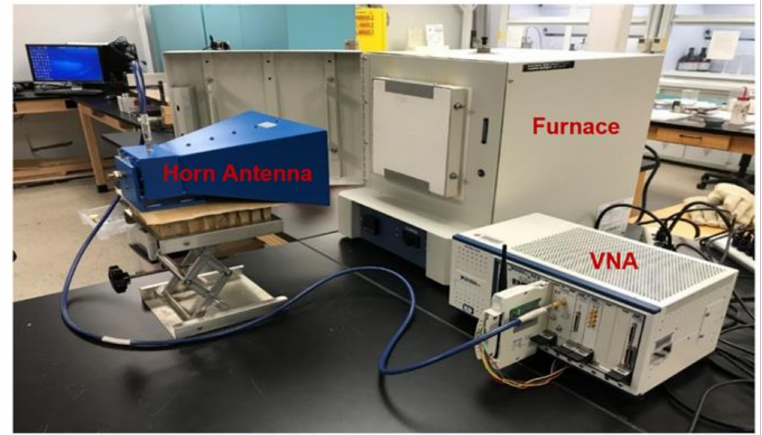
Figure 12. Temperature sensor experimental